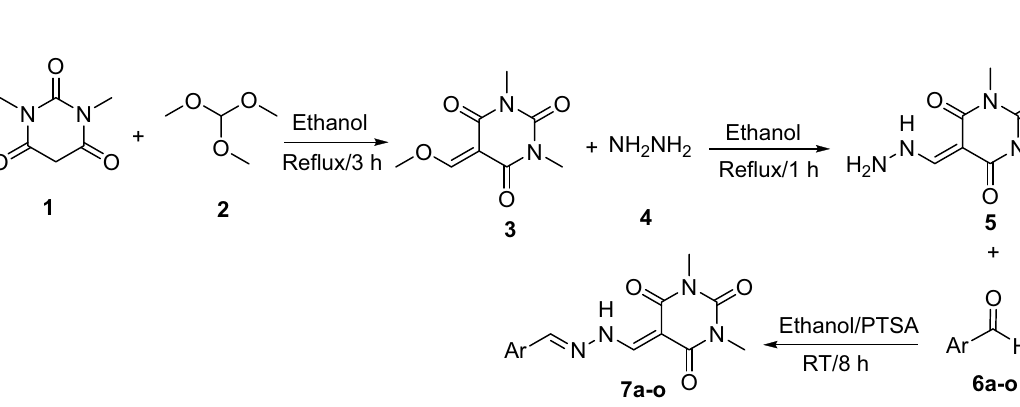
Figure 1. Design strategy for new arylmethylene hydrazine-1,3-dimethylbarbituric derivatives as urease inhibitors.